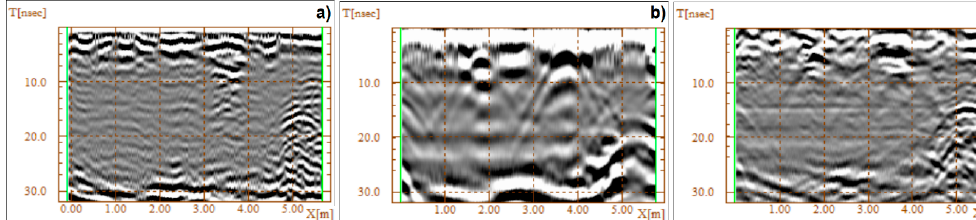
Figure 4. Profile 1: radargram relative to the frequencies of 600 MHz ( a ), 200 MHz ( b ), and in a cross- polar modality (Freq-Transmitter 200 MHz, Freq-Receiver 600 MHz) ( c ).